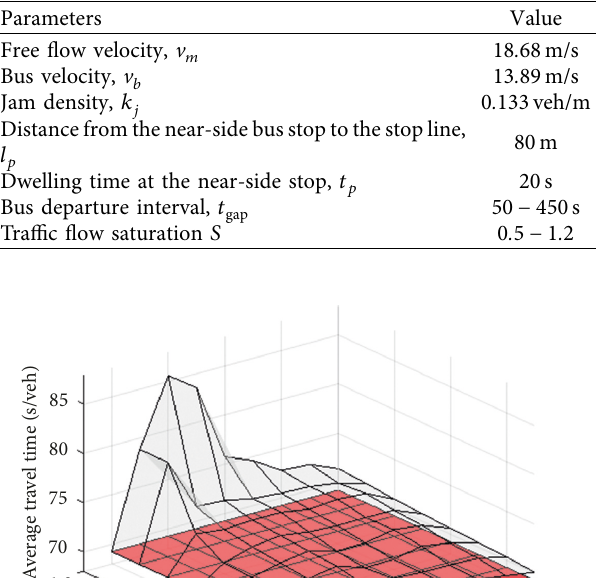
Table 1: Experimental simulation parameters.